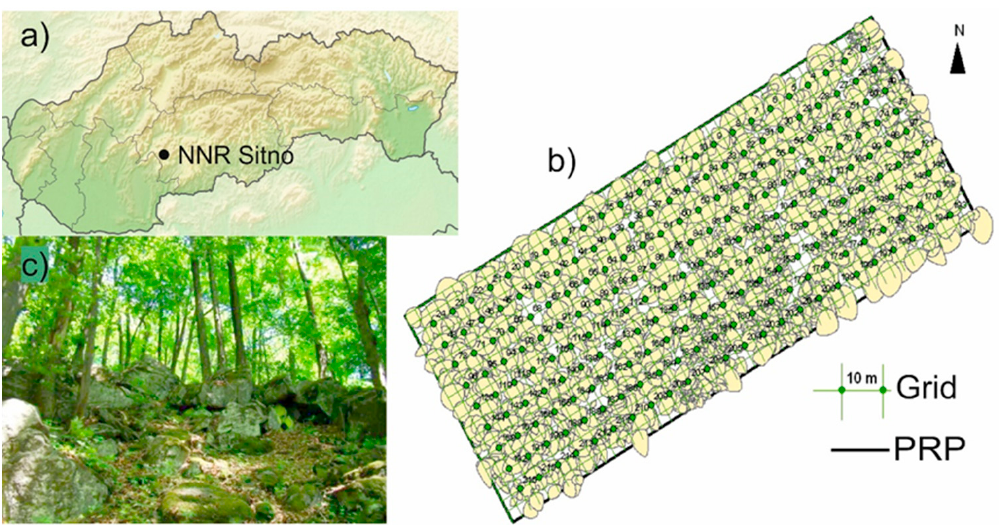
Figure 1. ( a ) Location of the National Nature Reserve (NNR) Sitno in Slovakia; ( b ) permanent research plot (PRP, 250 × 100 m) with horizontal cover of tree crowns and 216 circular research plots (plot size 3.14 m 2 , grid intersection 10 × 10 m) established to survey natural regeneration; the longer side of PRP follows the highest counter line; ( c ) intersection of Pannonian and mountain climate together with large stones and stony debris necessitated rich and diversified tree species composition of beech-oak old-growth forests in NNR